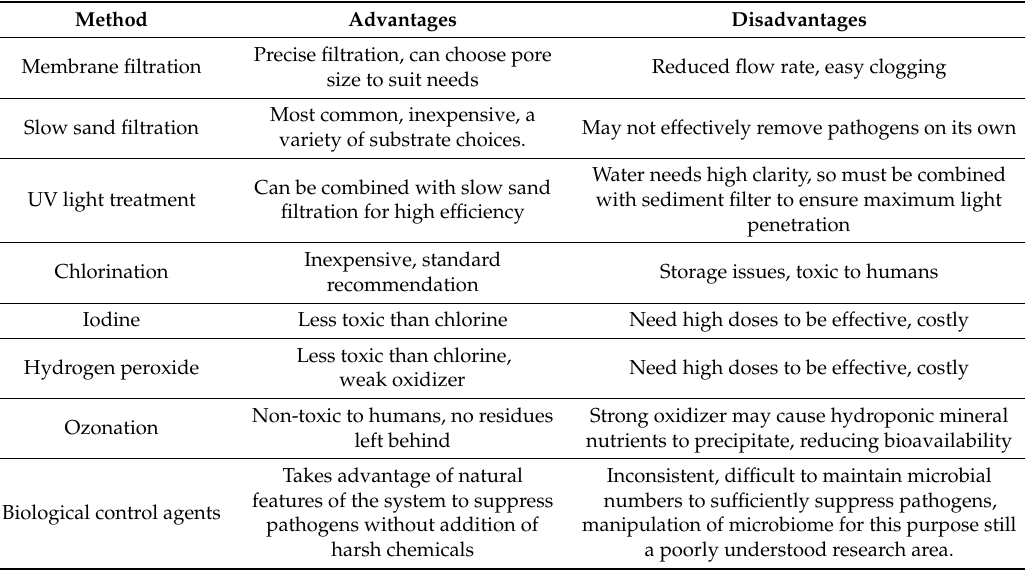
Table 3. Water treatment strategies and associated advantages and